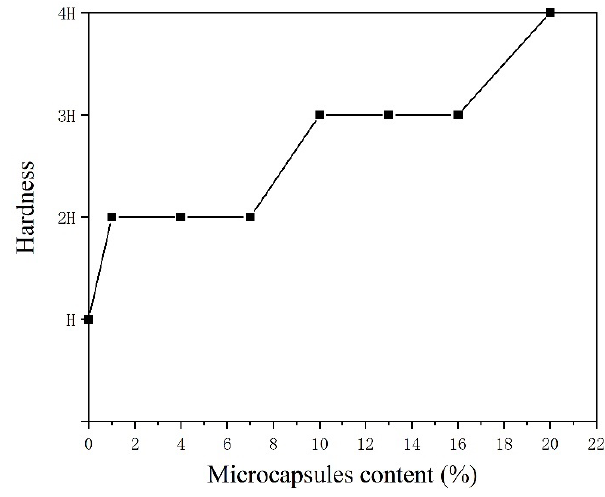
Figure 8. Hardness of the coatings.